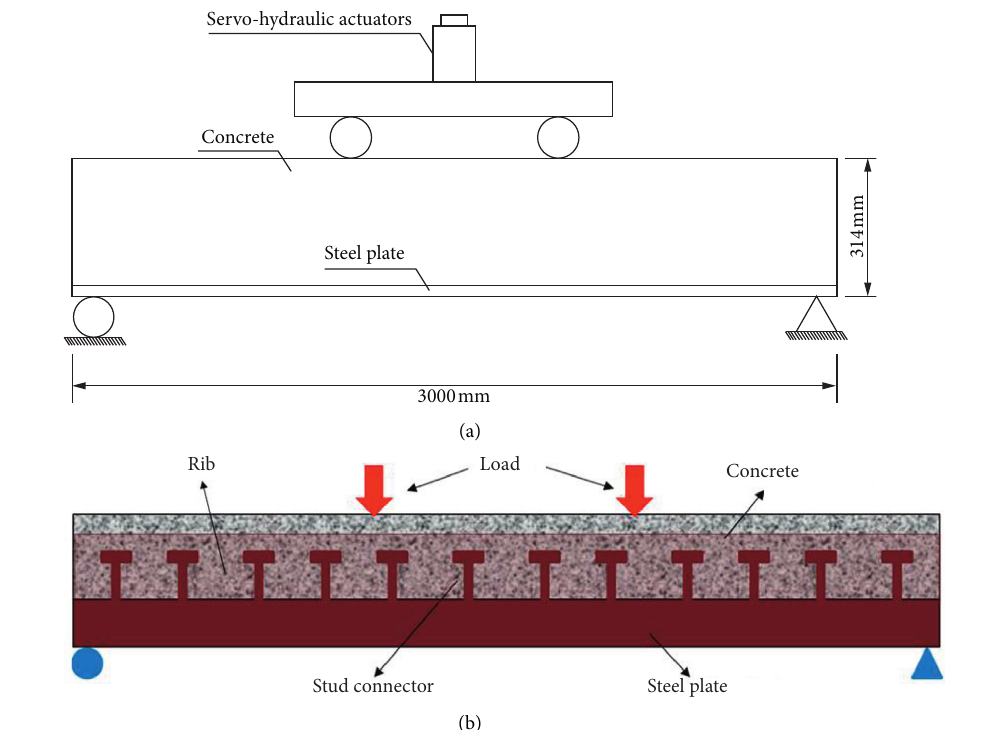
Figure 5: Test setup and instrumentation of specimens: (a) schematic diagram of test set-up and (b) general view.